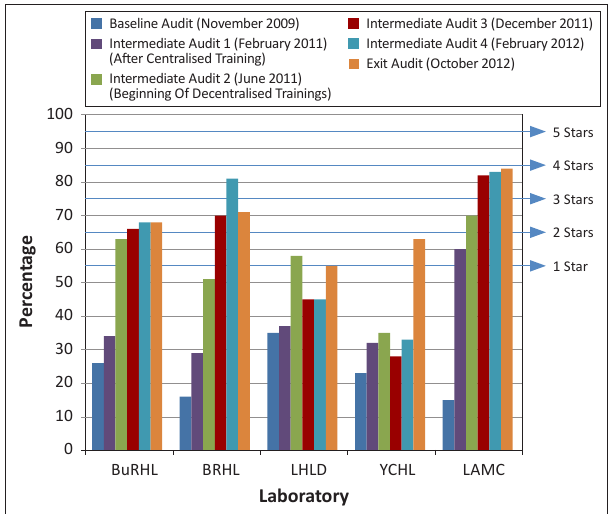
FIGURE 1: Performance of five Cameroon laboratories over 24 months of SLMTA implementation as measured by the SLIPTA checklist.